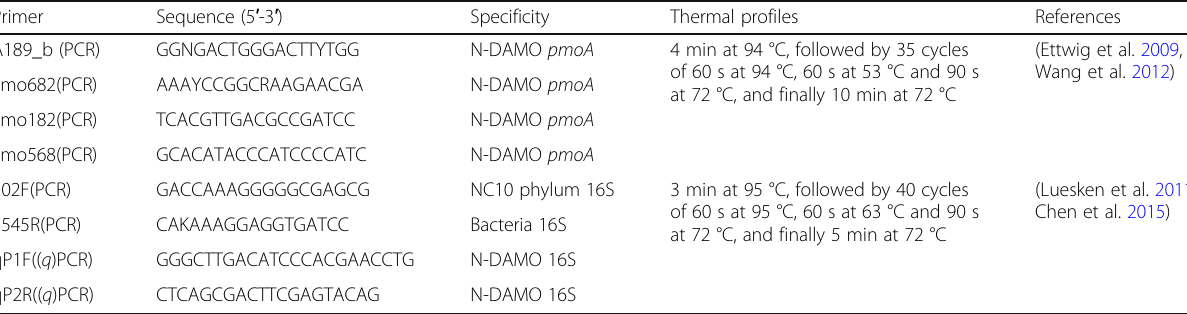
Table 1 The primers of 16S rRNA and pmoA genes, and thermal cycler procedures of polymerase chain reaction Primer Sequence (5 ′ -3 ′